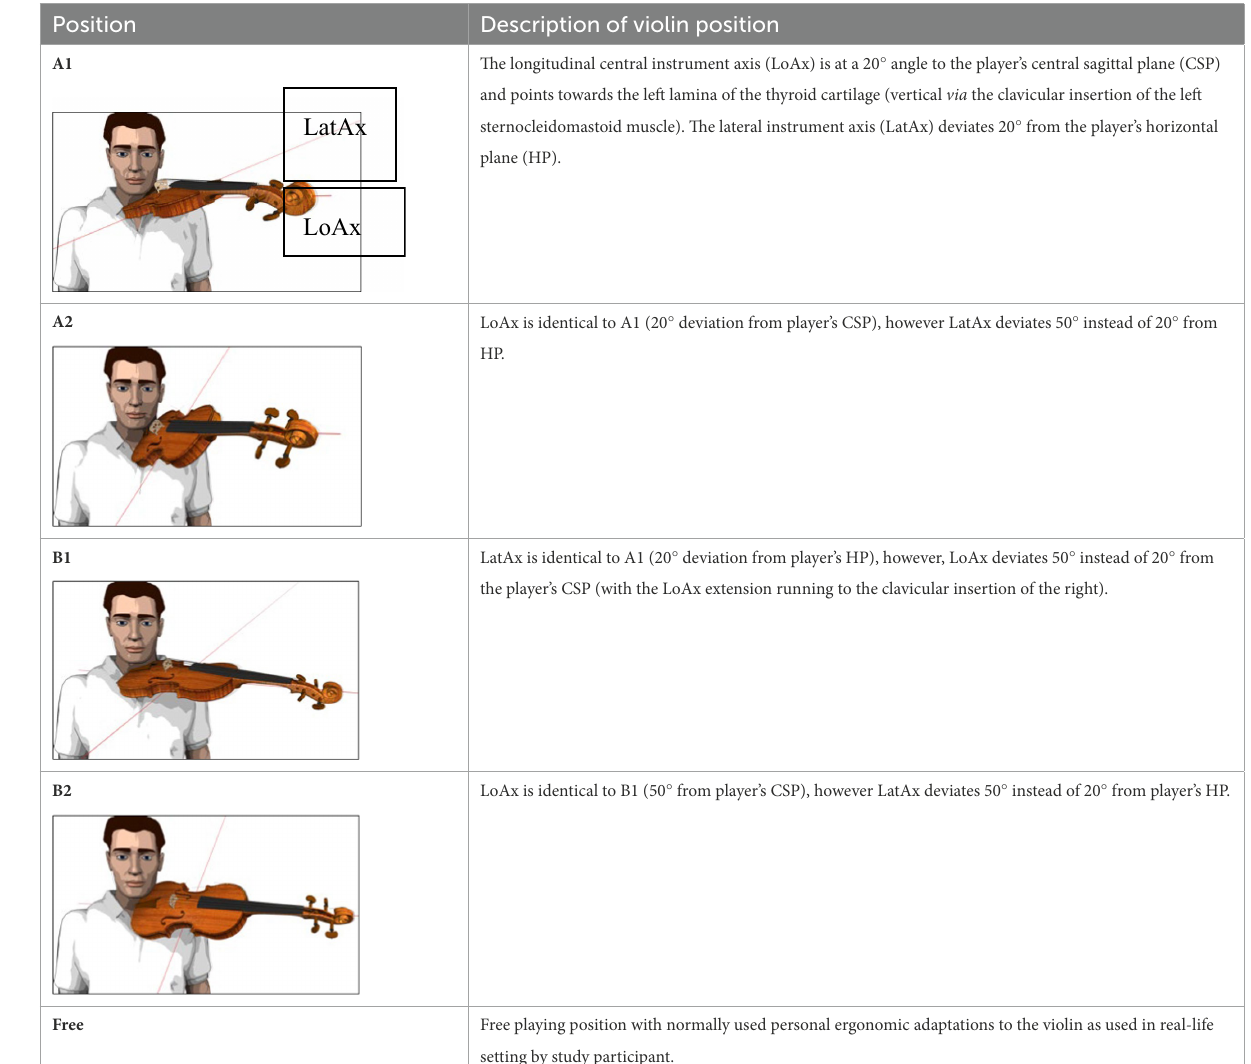
TABLE 1 Four standardized violin positions with orientation points and the free position. Position Description of violin